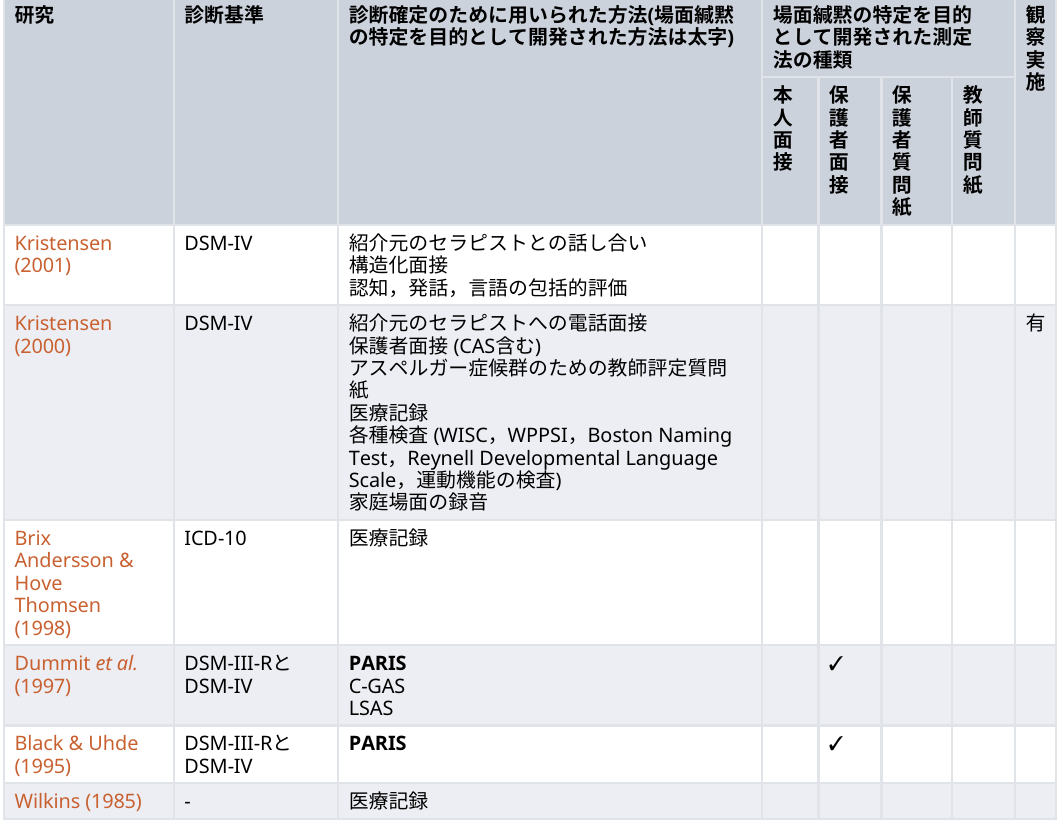
Table 2. 場 面 緘 黙 診 断 確 定 に 用 いられた 手 法 . ( 続 き ) 研 究 診 断 基